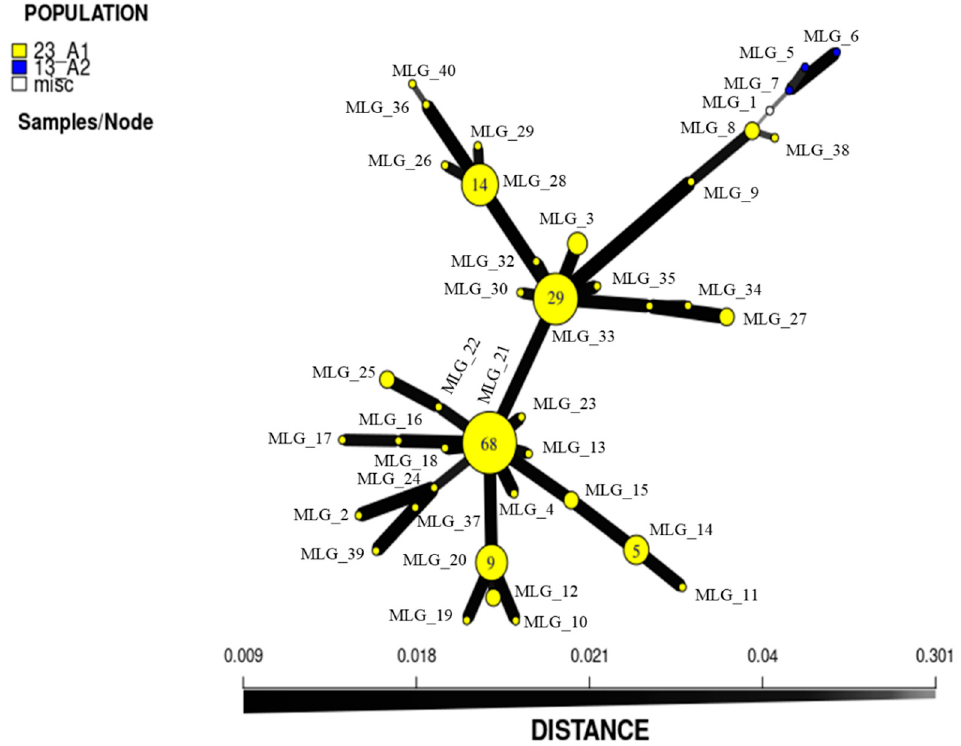
Figure 9. Minimum spanning network based on the Bruvo’s distance of the 167 P. infestans isolates using microsatellite (SSR) genotyping data. Nodes represent each multi-locus genotype, with the number of isolates indicated in the center of each circle. Lines connecting nodes with the lowest genetic distance are shown with thicker lines and the highest genetic distance is shown with thinner lines.